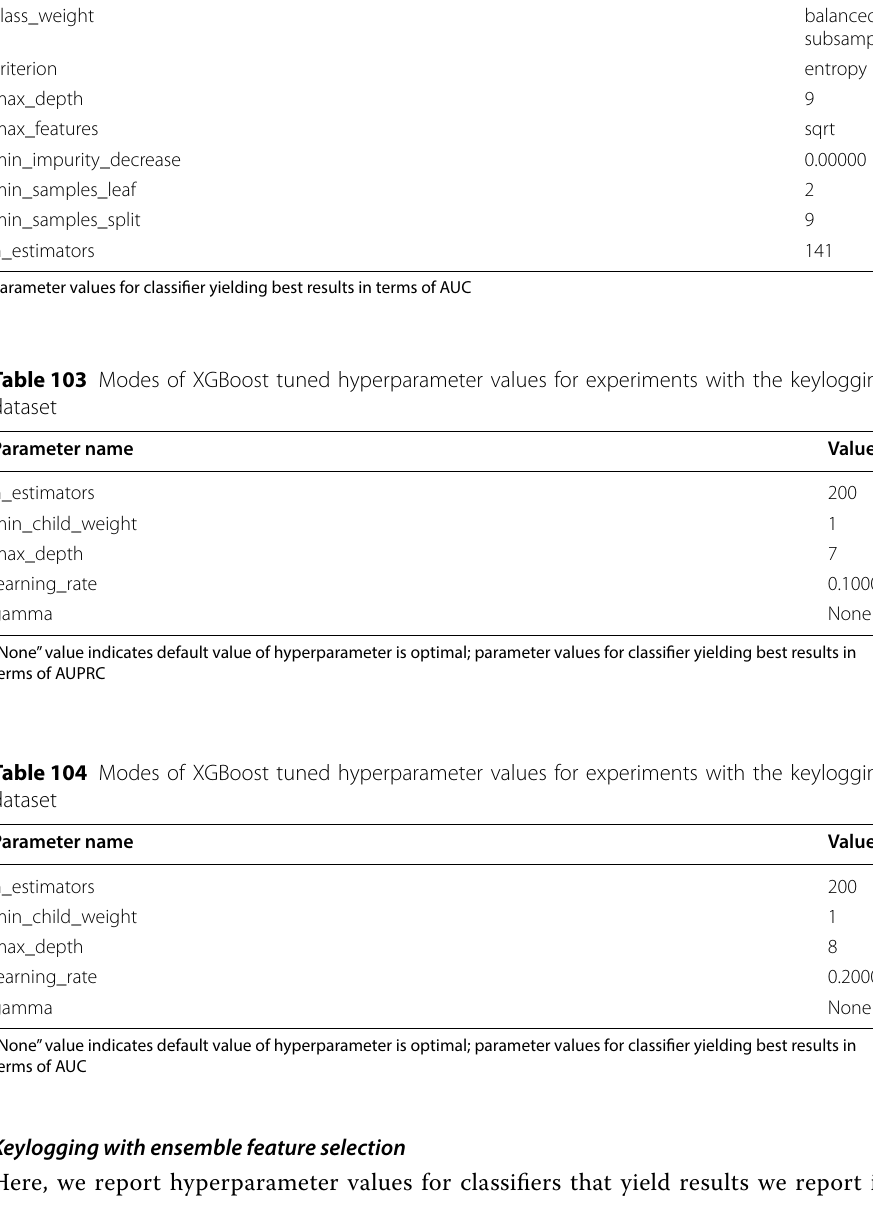
Keylogging with ensemble feature selection